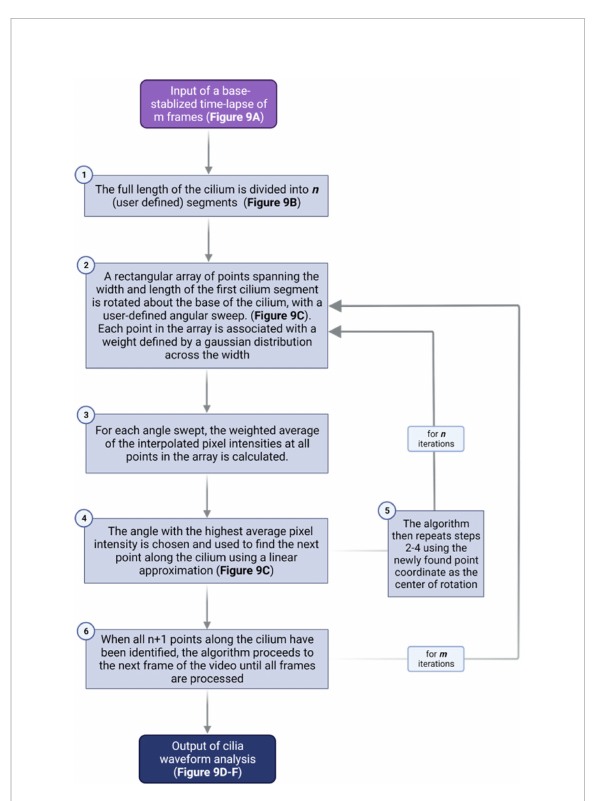
FIGURE 9 Flowchart outlining the algorithm for cilia waveform